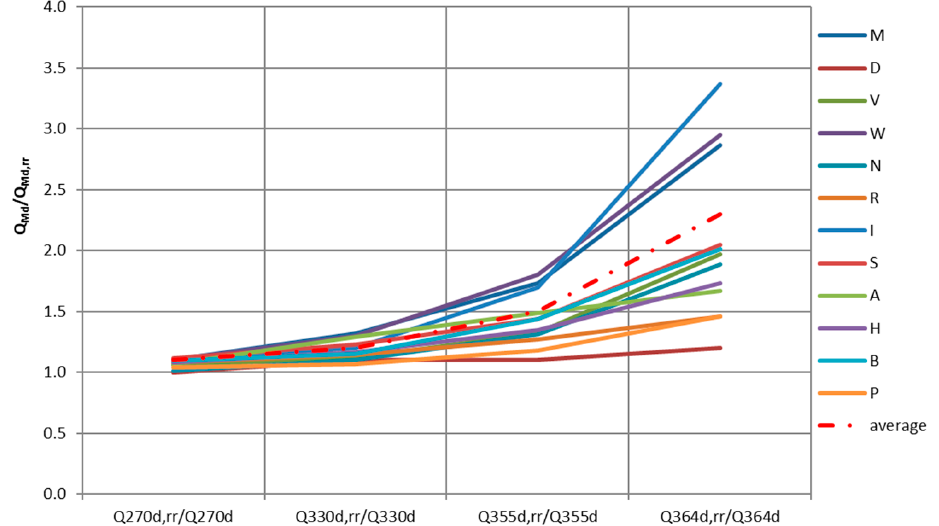
Figure 2. Comparison of Q Md values calculated using both methods in the 1961–2000 period (M—Morava, D—Danube, V—Váh, W—Malý Dunaj, N—Nitra, R—Hron, I—Ipe ľ , S—Slaná, A—Bodva, H—Hornád, B—Bodrog, P—Poprad).